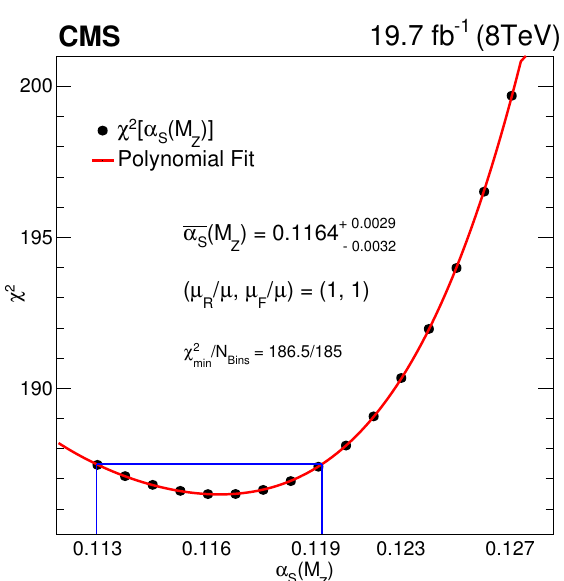
Figure 12 . The (cid:31) 2 minimization with respect to (cid:11) S ( M Z ) by using the CT10 NLO PDF set and data from all rapidity bins. The uncertainty is obtained from the (cid:11) S ( M Z ) values for which (cid:31) 2 is increased by one with respect to the minimum value, indicated by the box. The curve corresponds to a fourth-degree polynomial (cid:12)t through the available (cid:31) 2